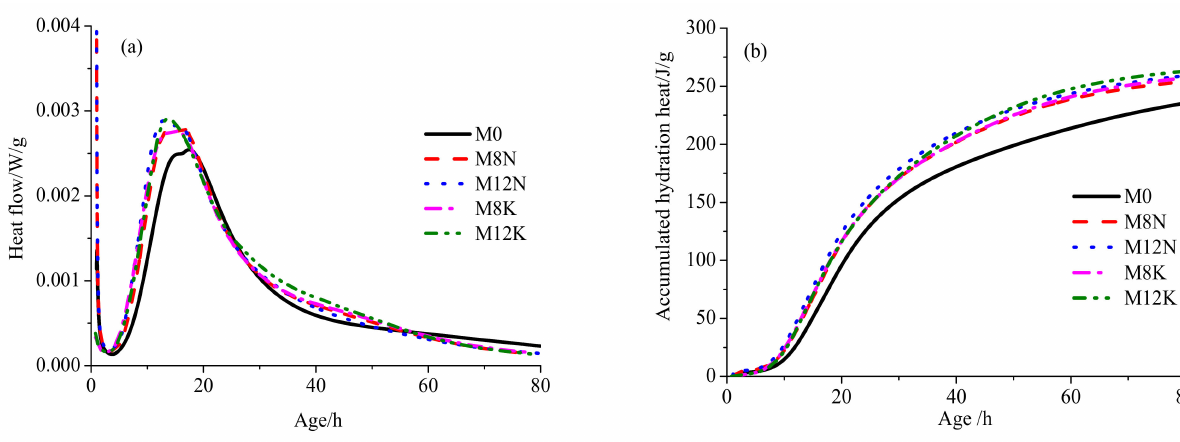
Figure 7. The heat flow ( a ) and accumulated hydration heat ( b ) of MHPC pastes with different alkali sulfates contents.